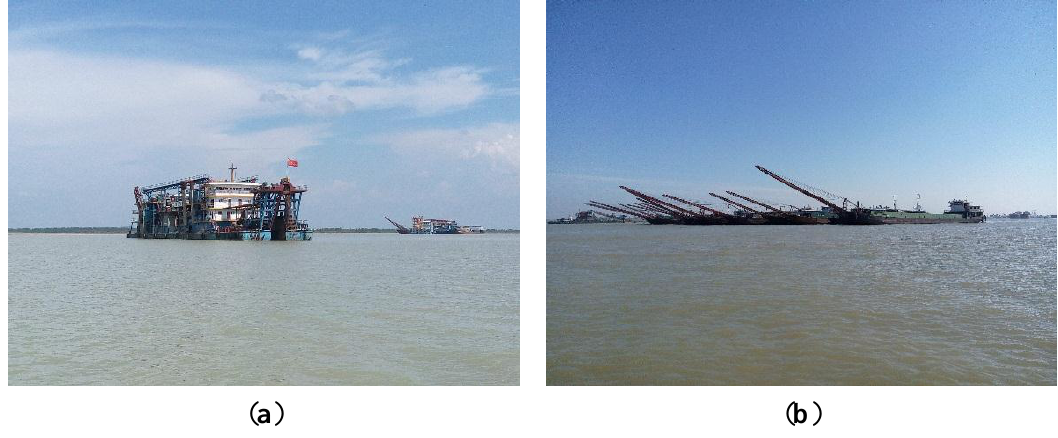
Figure 8. Digital photo taken at EDL on 7 August 2013 showing sand mining vessels ( a ) and automatic unloading vessels ( b